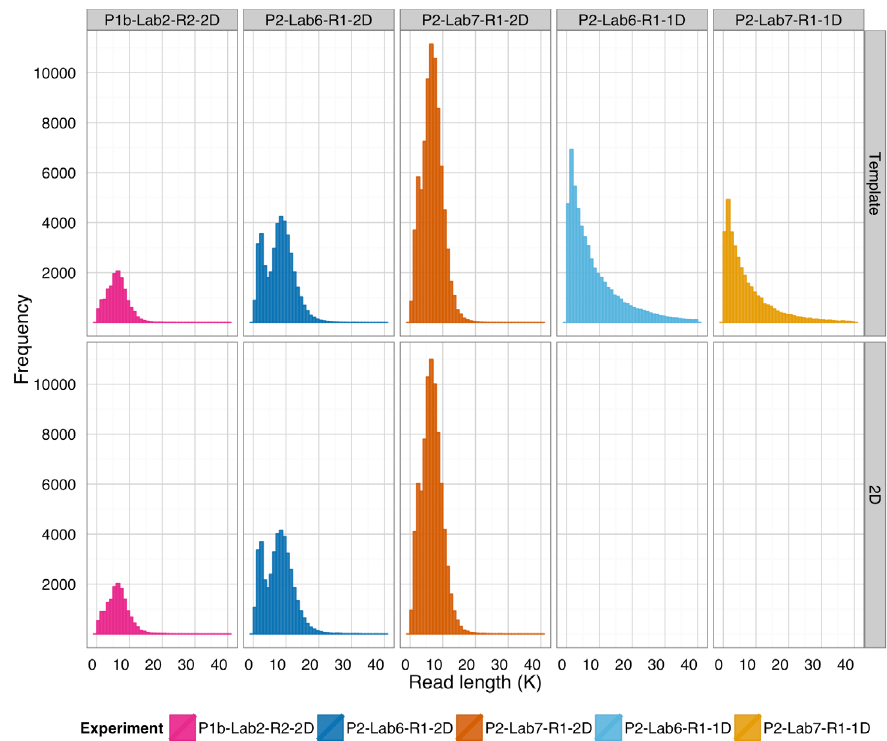
Figure 1. Read length distribution for template and 2D “pass” reads. The distribution of template (“1D”) read lengths for experiments based on 1D “rapid” libraries (P2-Lab6-R1-1D and P2-Lab7-R1-1D) was skewed toward shorter read lengths due to enzymatic, rather than mechanical, DNA fragmentation. The long tails of the distributions were truncated at 40,000 bases for